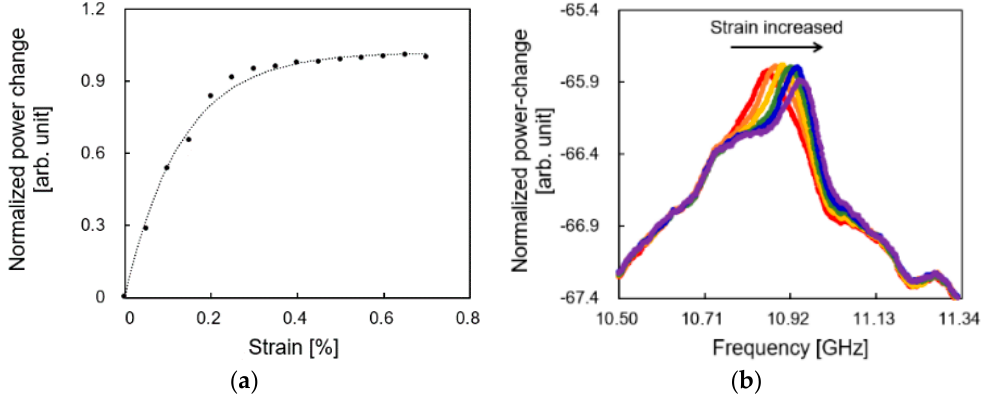
Figure 3. ( a ) Normalized power change plotted as a function of applied strain. The dotted curve is an exponential fit. ( b ) BGSs measured at strains of 0–0.25% (step: 0.05%) when the strained length L ε was the same as the nominal spatial resolution R .